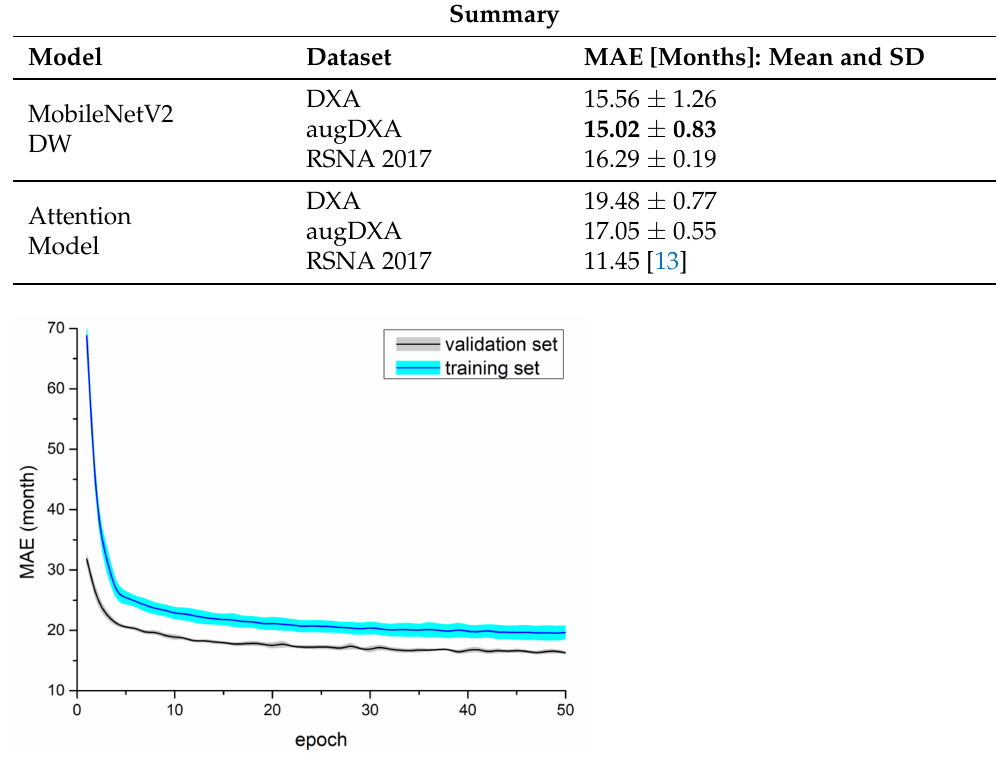
Figure 6. Training process for the MobileNetV2 DW model using the RSNA 2017 challenge dataset— mean and standard deviation calculated from five tests.